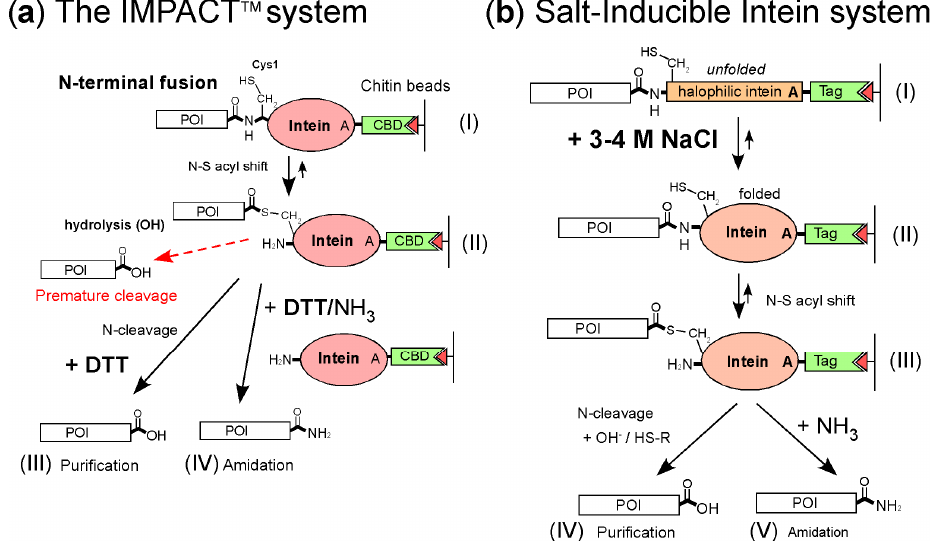
Figure 1. Schematic comparison between the two different purification systems ( a ) The IMPACT™ system from New England Biolabs for protein purification. The N-terminal fusion protein from a crude cell extract is purified by a chitin affinity column (I). The first N-S acyl migration of the fusion protein autocatalytically occurs and halts as the thioester intermediate due to the Ala mutation (II). The intein fusion protein is then induced to undergo on-column self-cleavage (arrow) by a reducing reagent such as dithiothreitol (DTT). The target protein is released from the column and eluted as a pure protein (III) [3,5]. The C-terminal amidation was achieved by adding DTT/ammonium ion (IV) [8]. The thioester intermediate after the first N-S acyl step could be immediately hydrolyzed, resulting in premature cleavage (a broken red arrow). ( b ) The salt-inducible intein system was developed for protein purification and amidation. The N-terminal fusion protein from a crude cell extract is purified using an affinity tag by a chitin affinity column or immobilized metal affinity chromatography (IMAC) (I). A high salt concentration of 3-4 M NaCl induces a strictly halophilic intein folding (II), and the intein undergoes an N-S acyl shift (III) [12]. The Ala mutation halts the thioester intermediate after the first N-S acyl step, cleaving through a reducing agent (IV). A high concentration of ammonium ions induces C-terminal amidation under a reducing condition using DTT (V).